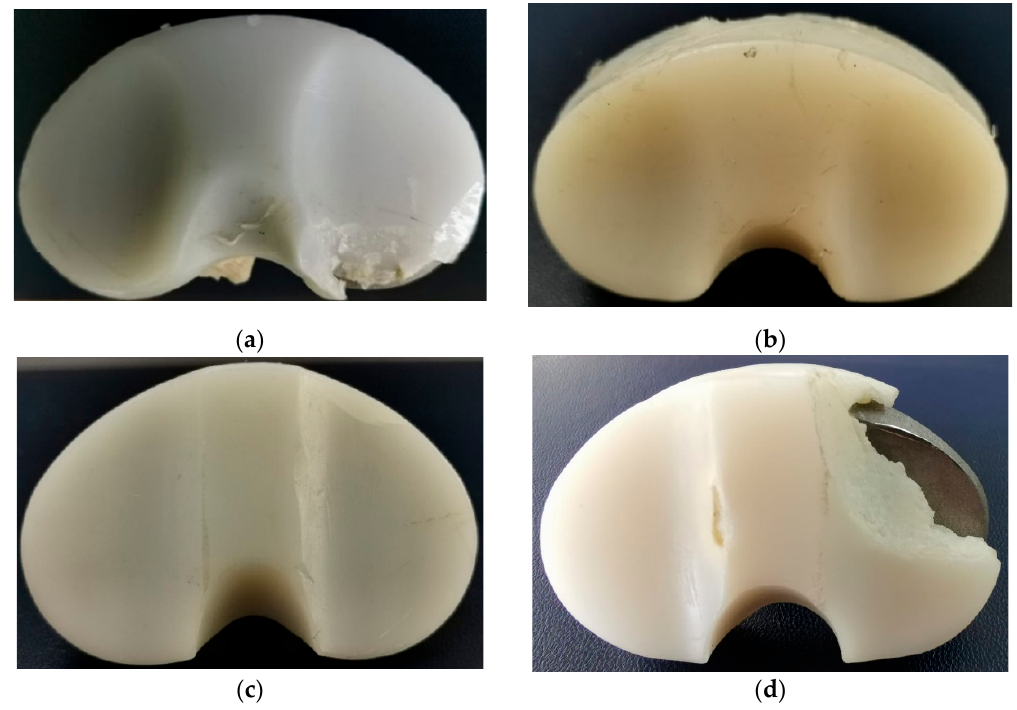
Figure 3. Macrophotographs of the UHMWPE tibial inserts retrieved from patients of Clinical Hospital Colentina. ( a ) IT1 sample—M2, M4, M5, M7 deterioration modes; ( b ) IT2 sample—M2, M3, M5, M7 deterioration modes; ( c ) IT3 sample—M1, M2, M3, M7 deterioration modes; ( d ) IT4 sample—M1, M2, M3, M4, M5, M7.